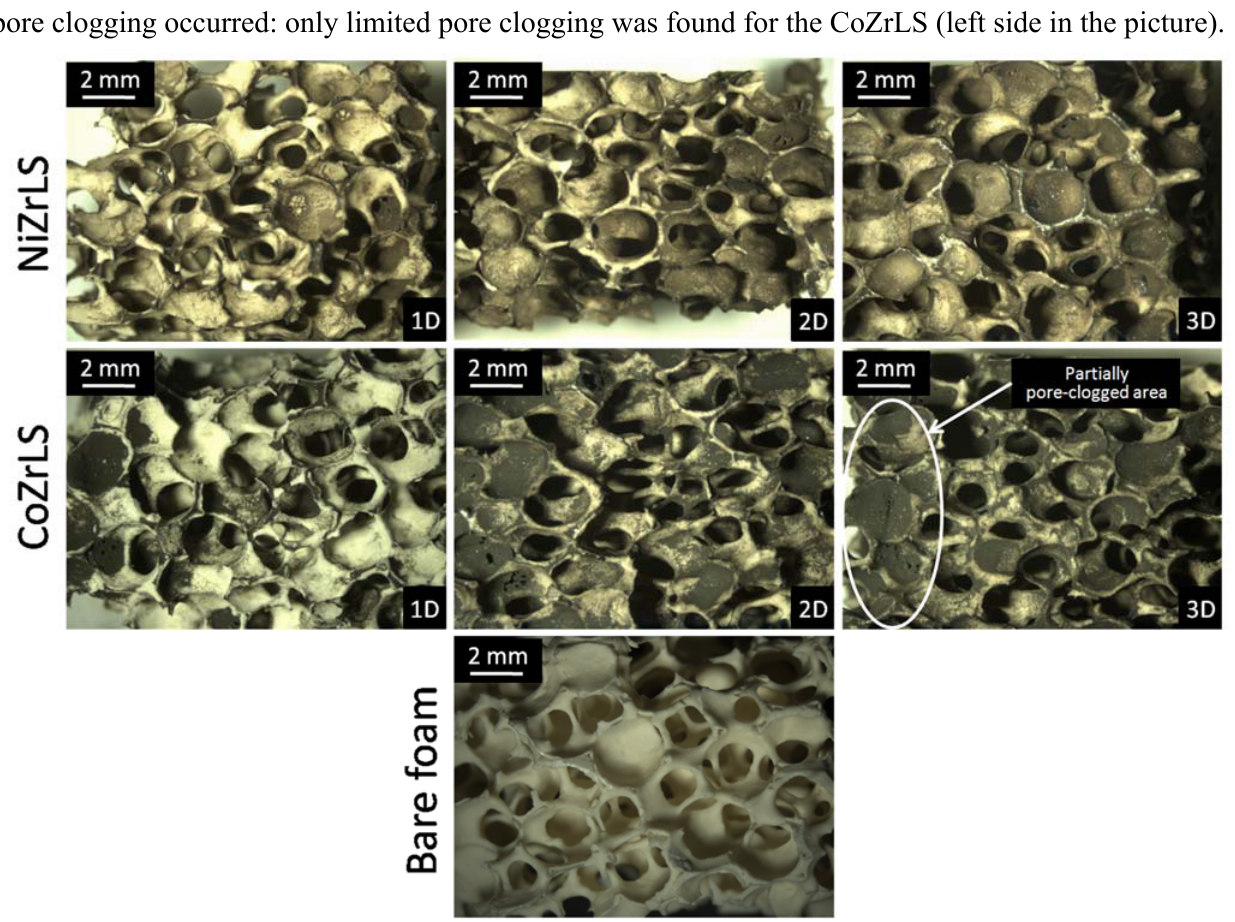
Figure 8. Optical images of NiZrLS (1D to3D) and CoZrLS (1D to3D) deposited on 30 PPI foams: effect of multiple dippings after flash drying. For the sake of comparison, an image of the bare foam has been added at the bottom of the